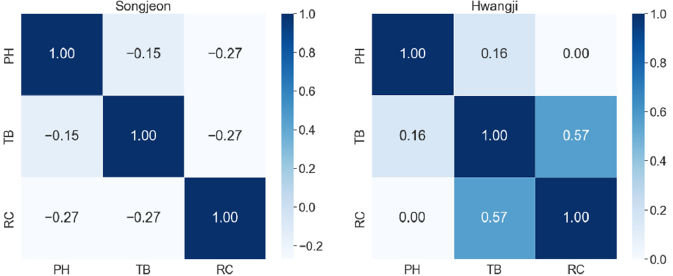
9 of 24 Figure 3. Descriptive statistics of the water quality parameters analyzed in this study: ( a ) PH, ( b ) TB, and ( c ) RC. 4.1. Correlation Analysis